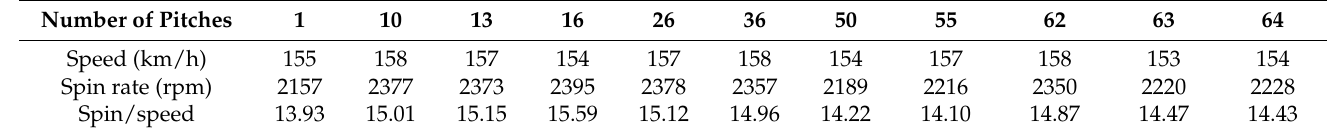
Table 5. Pitching state analysis of four-seam fastballs by Shohei Ohtani.